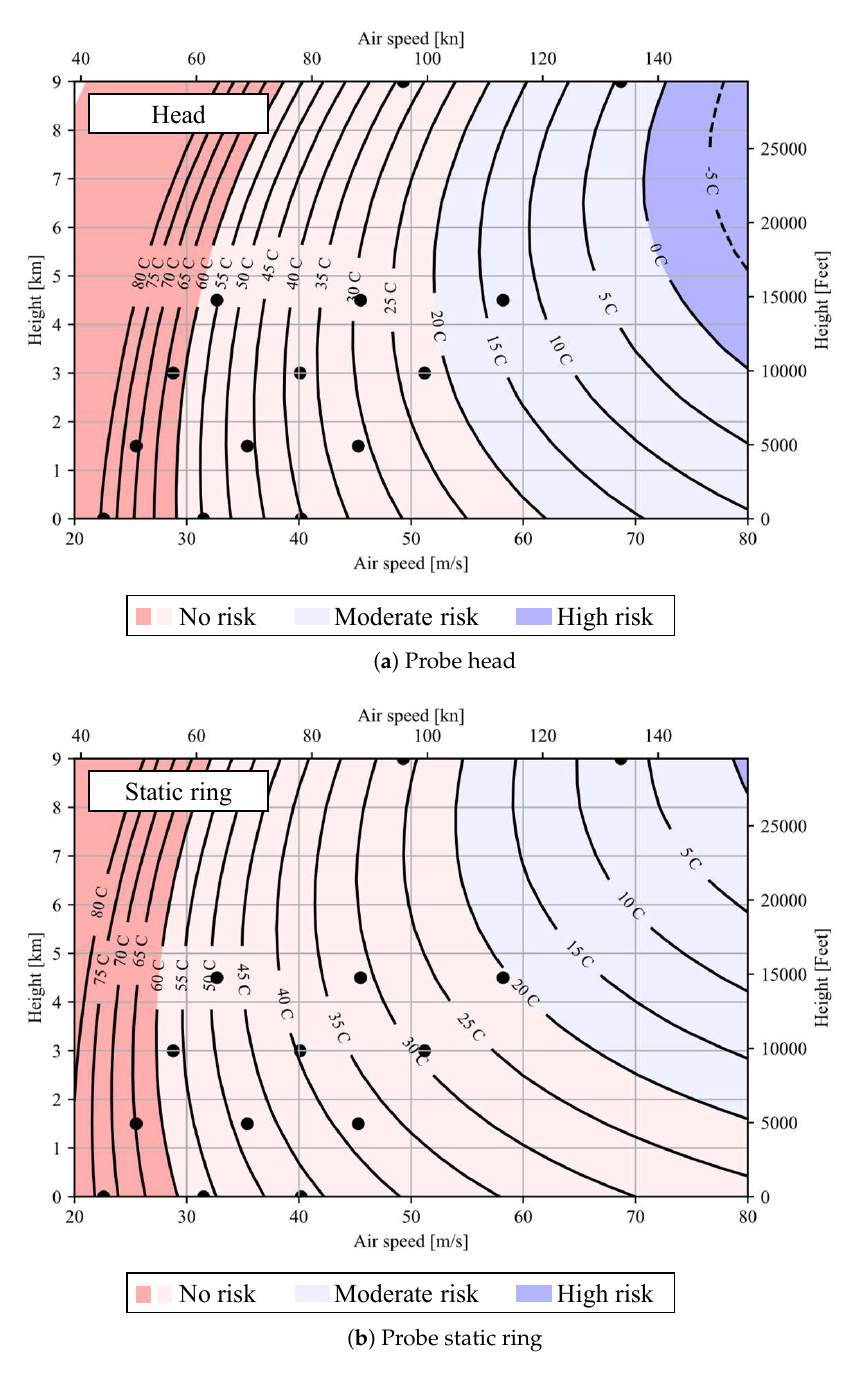
Figure 16. Anti-icing evaluation graph for the probe showing the accordance between the test translated data and the predicted temperature values by the regression